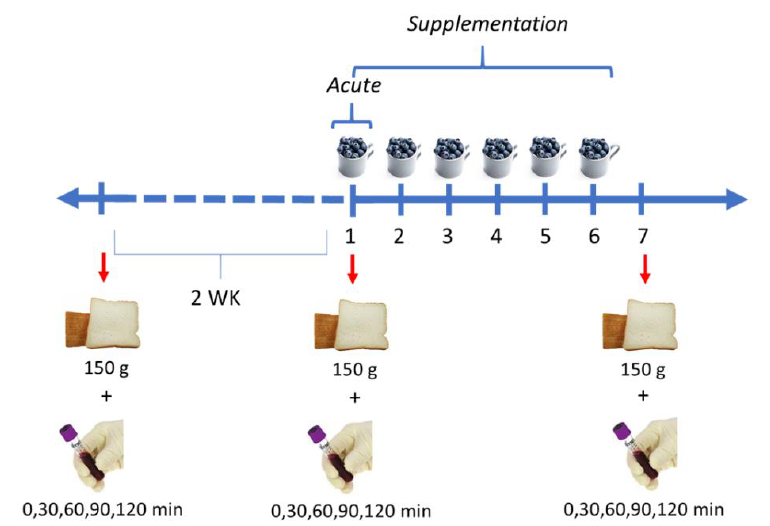
Figure 1. Design of the acute intervention and short-term supplementation. Acute intervention and short-term supplementation were separated by 2 weeks (WK).